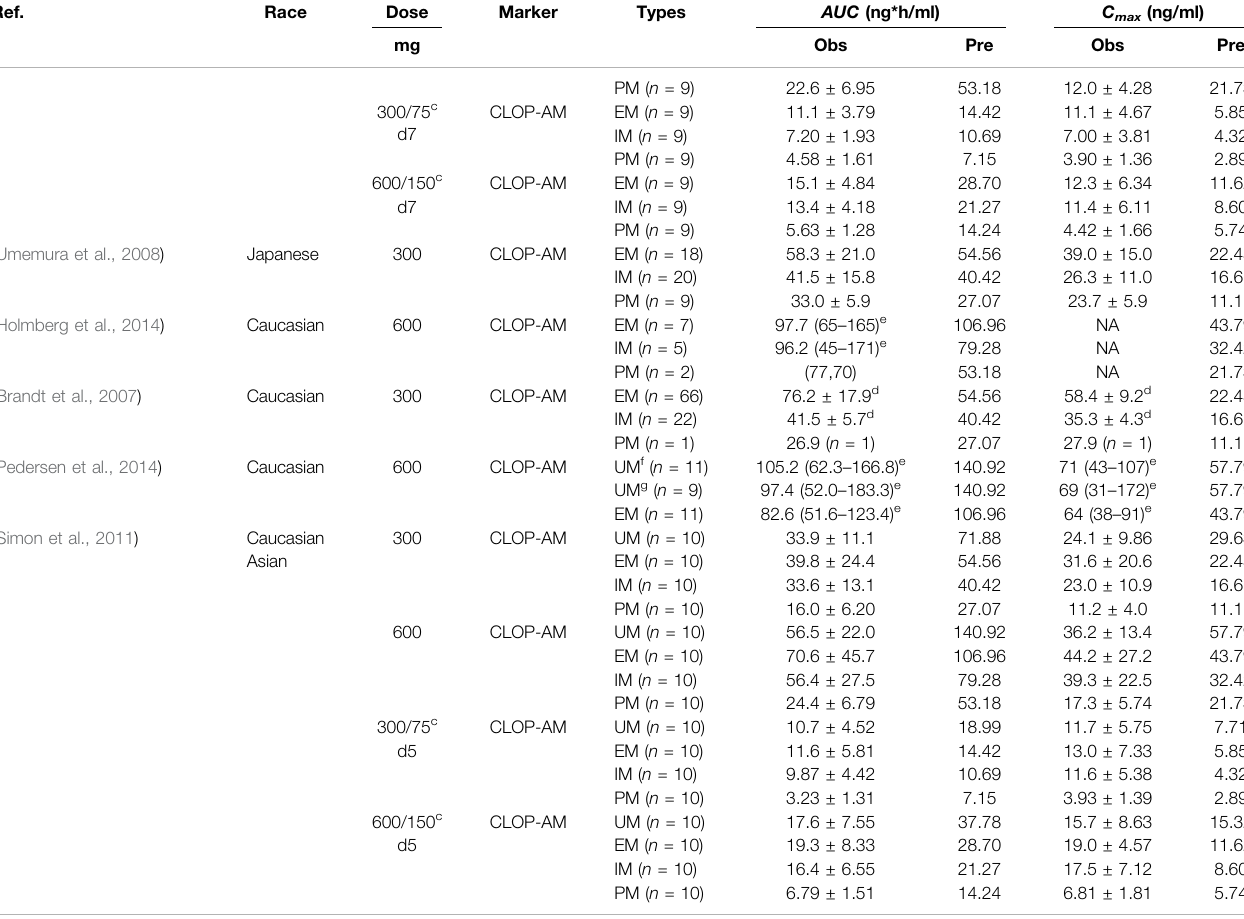
TABLE 4 | ( Continued ) The observed and predicted plasma pharmacokinetics parameters in healthy subjects.